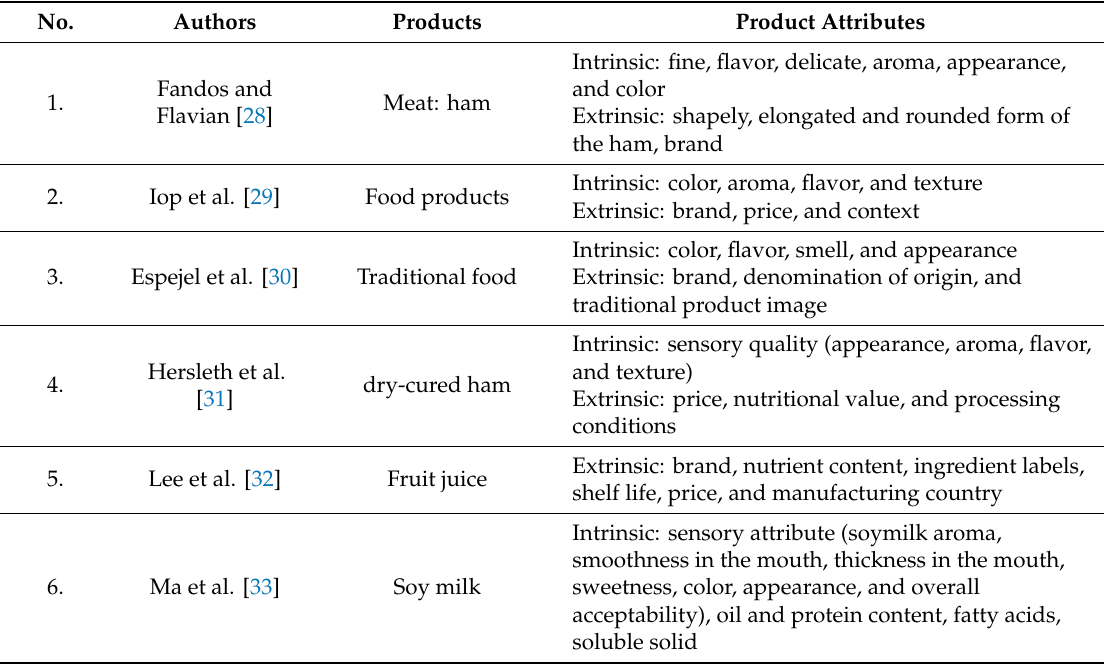
Table 1. Product attributes in the food